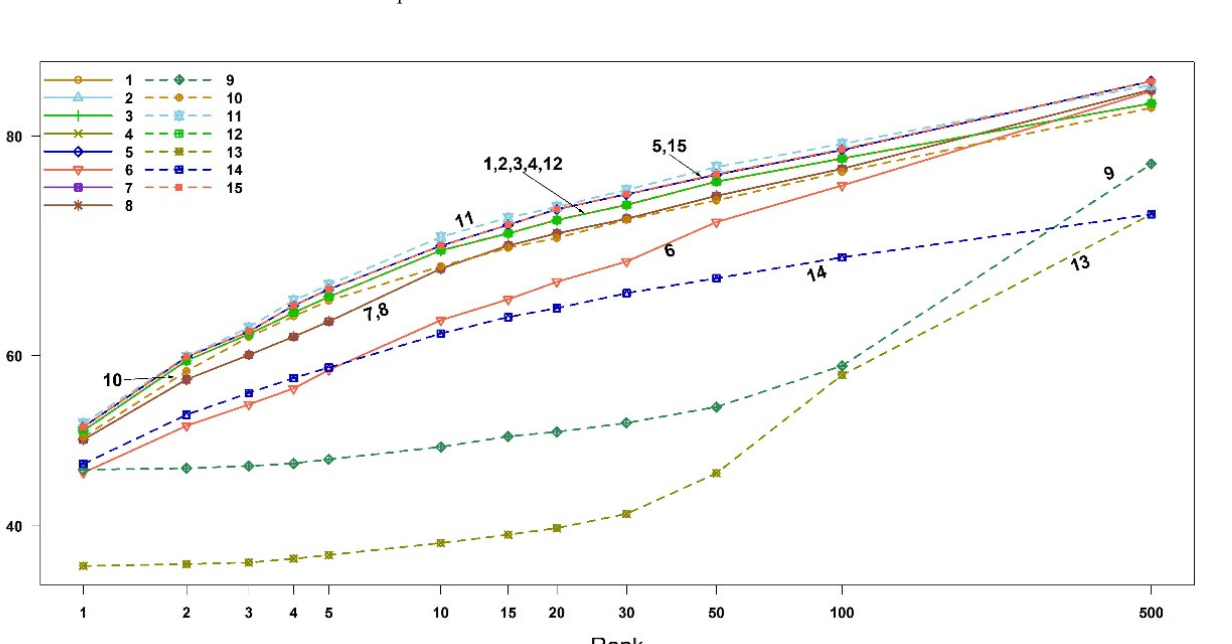
The numbers in parentheses are 95% CI.